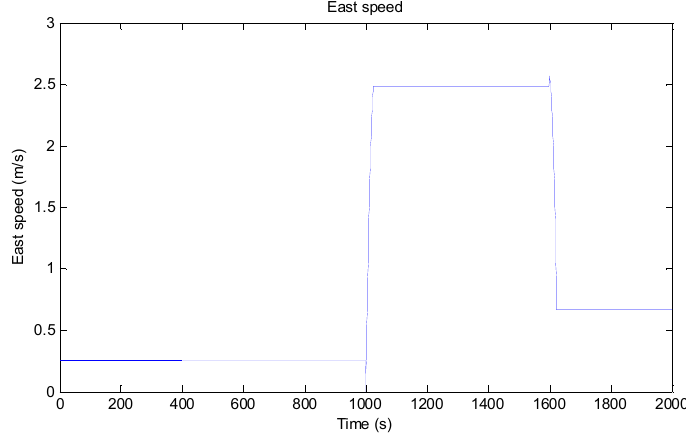
Figure 4. Schematic diagram of the AUV’s eastward speed.